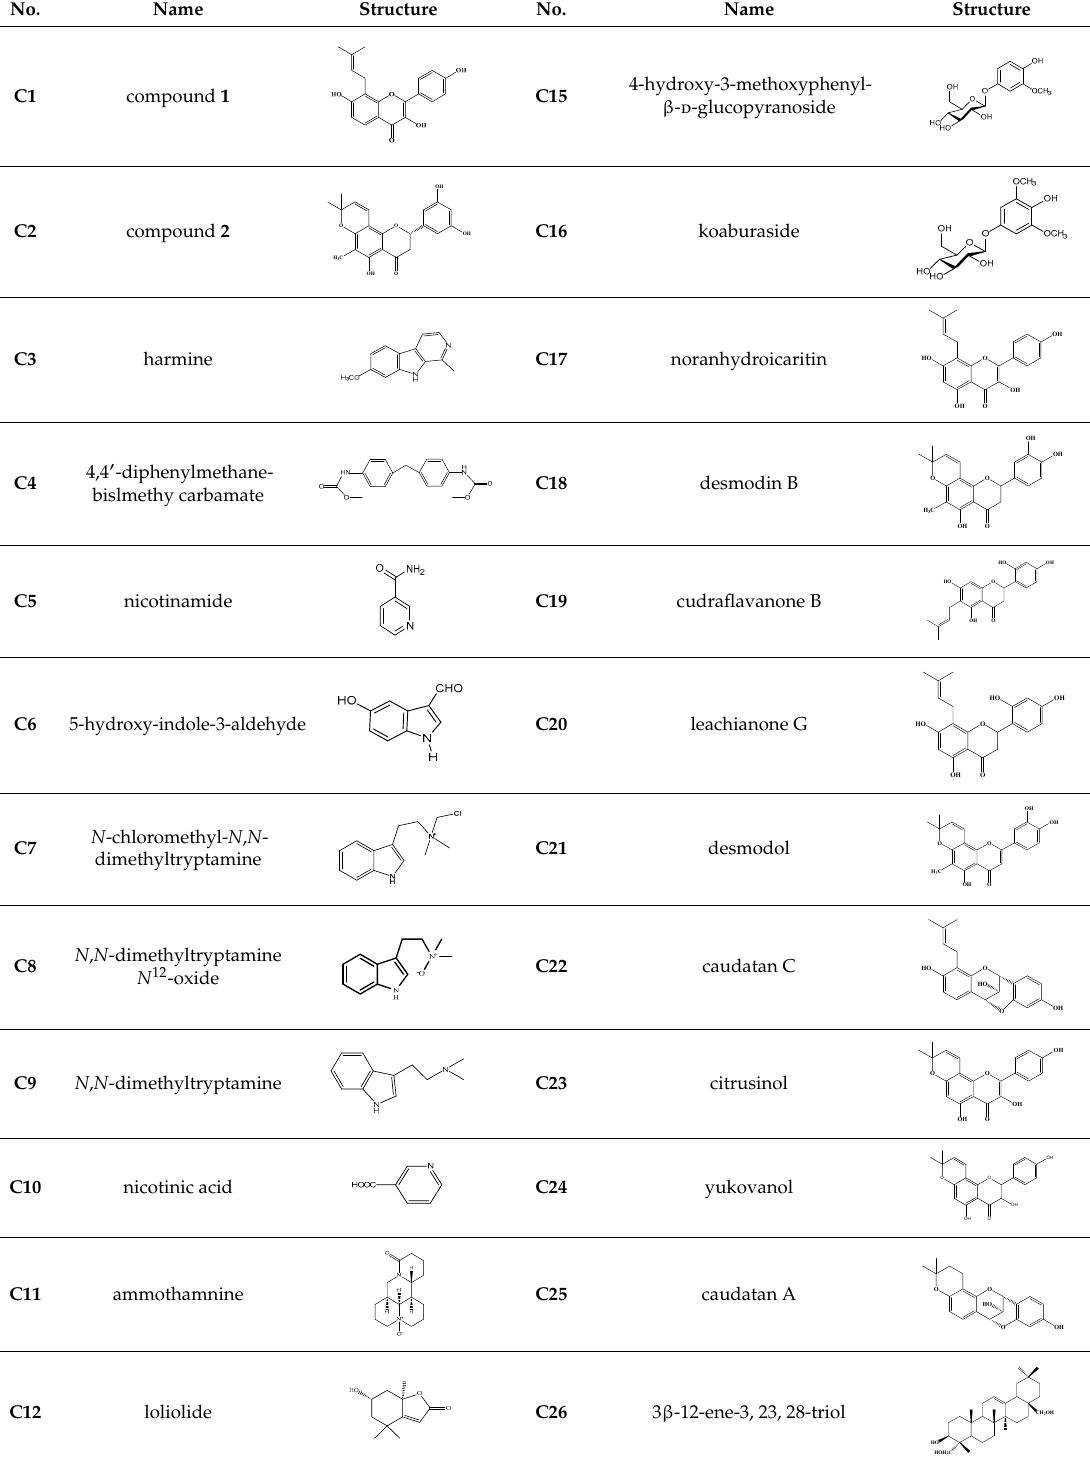
Table 3. 28 potential active compounds of Ohwia caudata (OC).